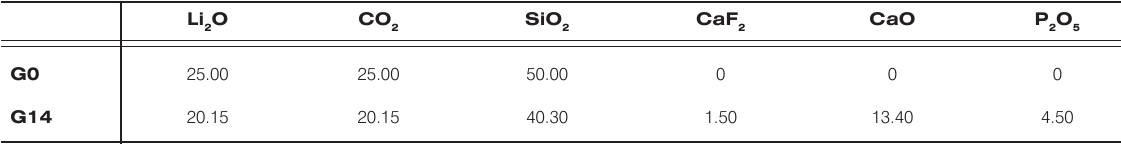
Table 1. Nominal composition of synthesized glasses (%).